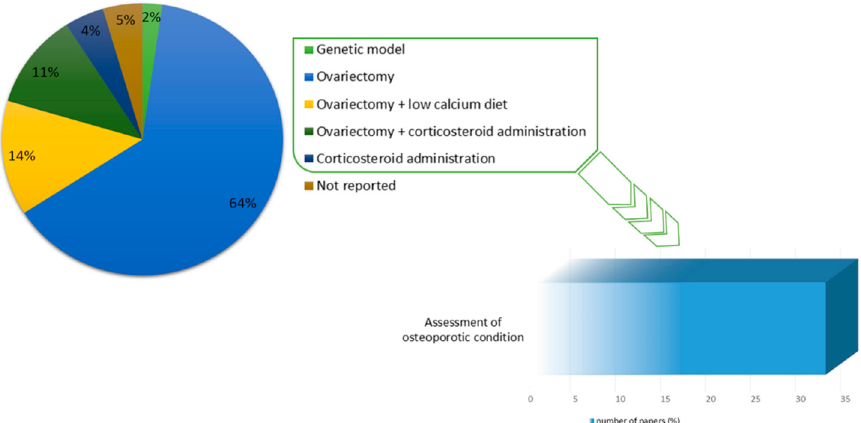
Figure 3. Pie chart of the methods used for inducing osteoporosis in the preclinical models. Histogram shows the percentage of preclinical studies reporting to have performed assessments of the establishment of the osteoporotic condition before implantation surgery (33%).